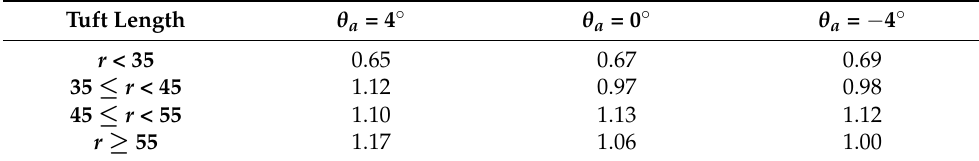
Figure 9. Transient oscillation of luminescent mini-tuft variations with their transversal position on the model ( r ’s unit is mm). ( a ) θ a = 4°; ( b ) θ a = 0°; ( c ) θ a = − 4°. Table 1. Mean values of A / A ref with different tuft lengths.